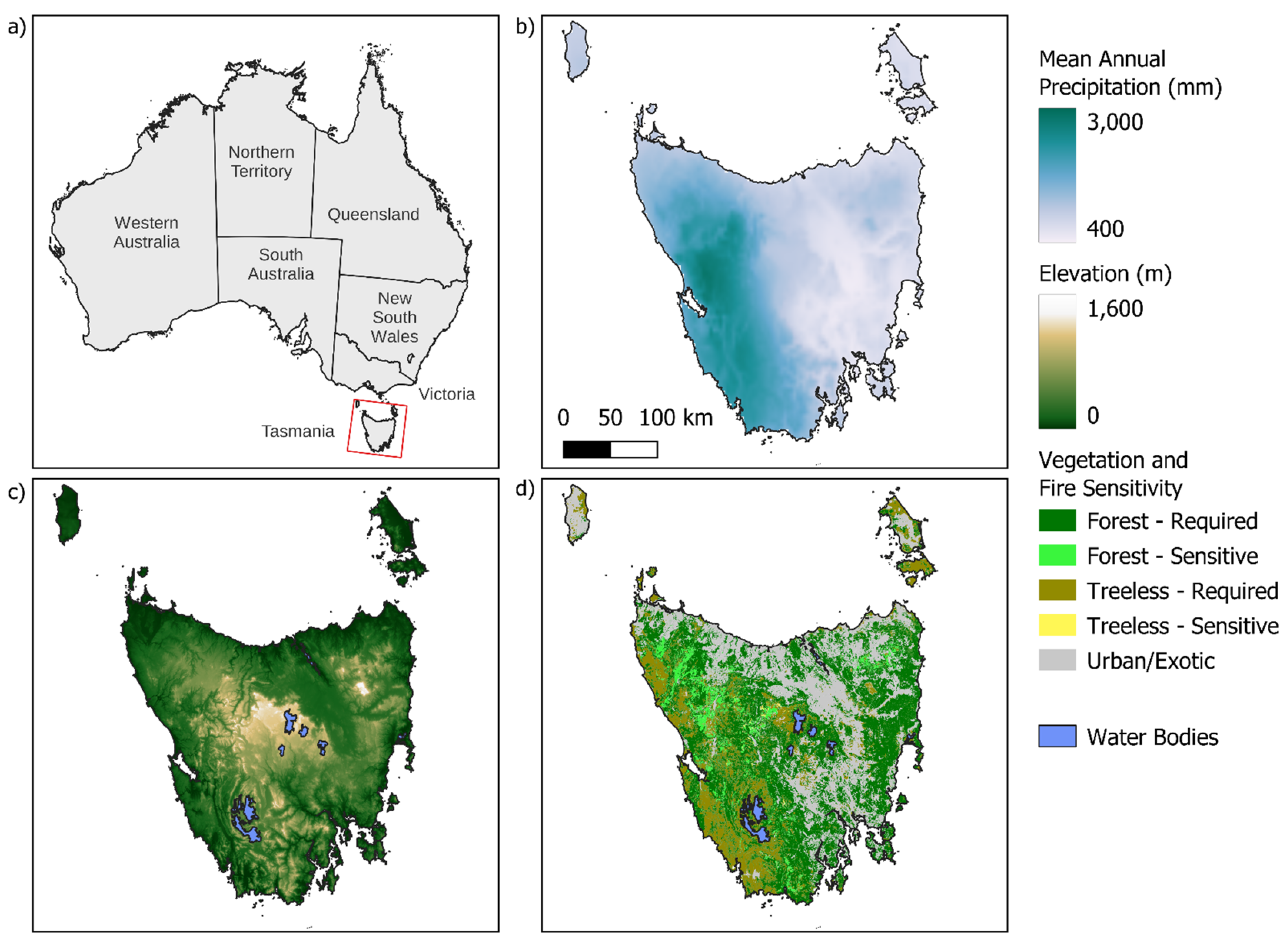
Figure 1. Geography of Tasmania. a. location of Tasmania with respect to mainland Australia Patterns of: b. mean annual precipitation [8]; c. elevation [9]; d. forest/woodland and treeless vegetation broken down by fire requiring and fire sensitive types, derived from TasVeg 4.0 mapping [10].